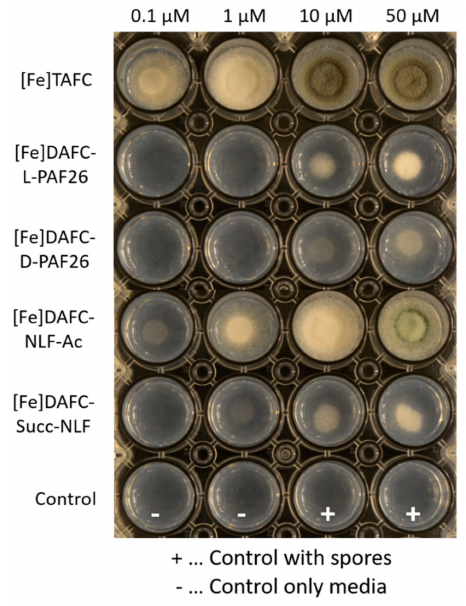
Figure 3. Growth promotion of A. fumigatus mutant strain ∆ sidA / ∆ ftrA after 72 h incubation at 37 ◦ C on iron-depleted Aspergillus minimal media (AMM) with di ff erent concentrations of iron labelled conjugates. Whitish hyphal growth can be distinguished from greenish sporulating growth due to the green pigmentation of conidia. The bottom row shows control without siderophores.